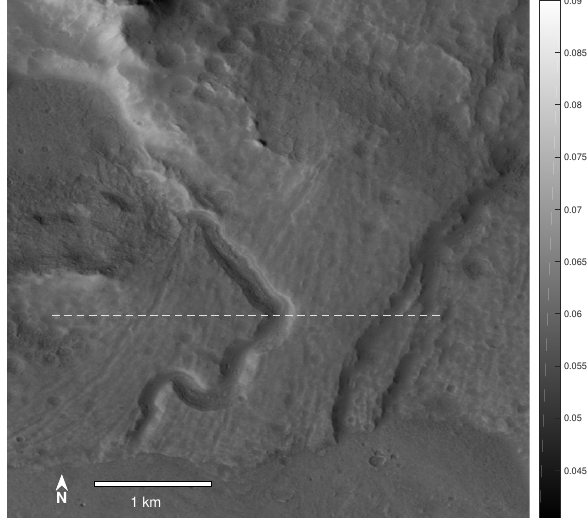
Figure 2. Image in I/F of the region of interest taken from CTX image G20 025970 2217 XN 41N102W. The yellow dashed line indicates the profile which will be investigated further in the following figures.